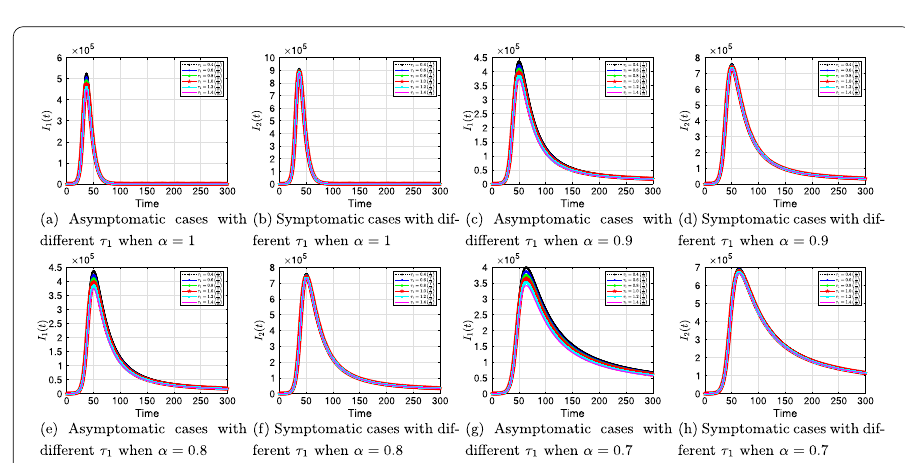
Figure 10 Solution profiles for the COVID-19 model with different τ 1 across different fractional order α